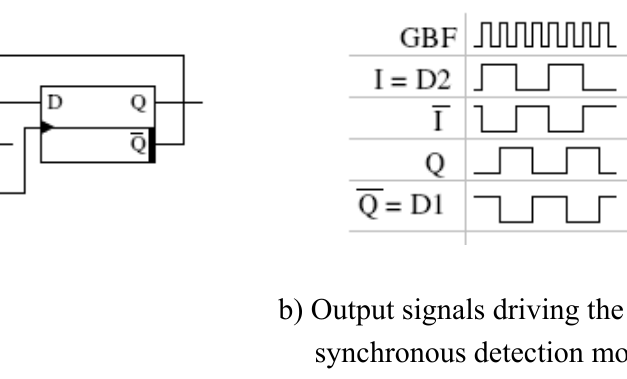
Figure 9. The phase converter and its outputs signals.